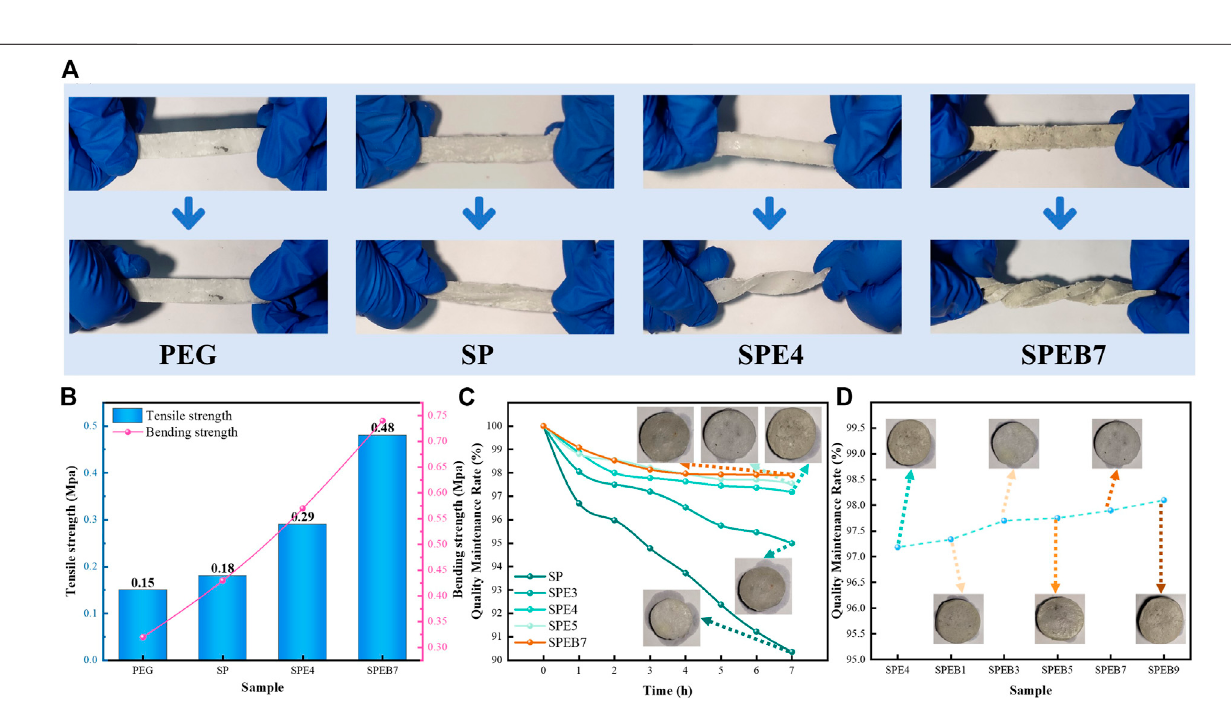
Frontiers in Energy Research |